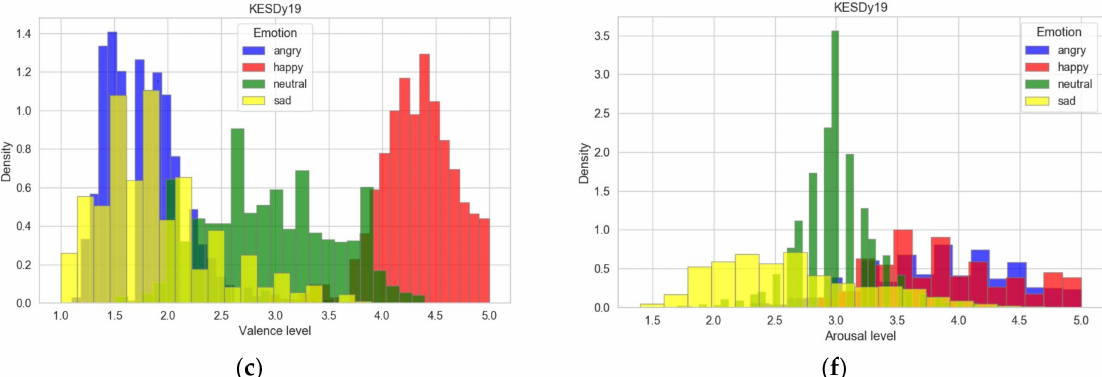
Figure 4. Distribution between discrete and dimensional emotion labels of the five-point scale: ( a ) distribution of discrete and valence-level labels of Interactive Emotional Dyadic Motion Capture database (IEMOCAP); ( b ) distribution of discrete and valence-level of KESDy18; ( c ) distribution of discrete and valence-level of KESDy19; ( d ) distribution of discrete and arousal-level of IEMOCAP; ( e ) distribution of discrete and arousal-level of KESDy18; and ( f ) distribution of discrete and arousal-level of KESDy19.